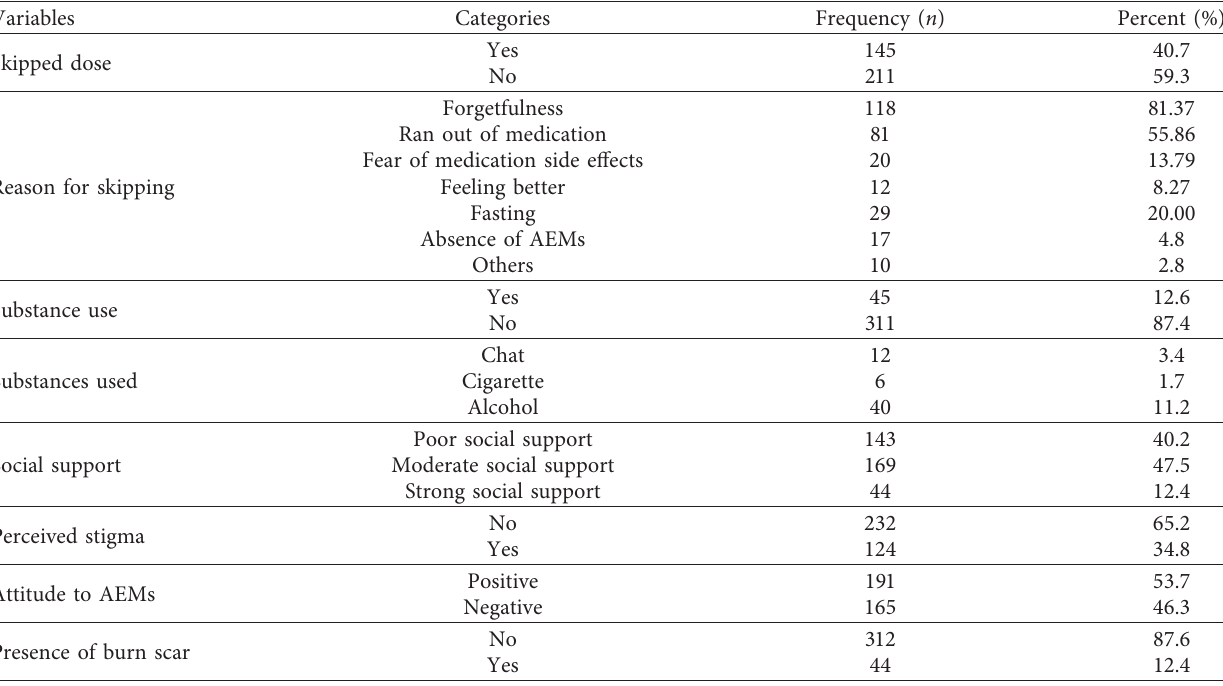
Table 3: Distribution of antiepileptic patients by patient-related factors at UGCSH, Ethiopia, 2019 ( n �